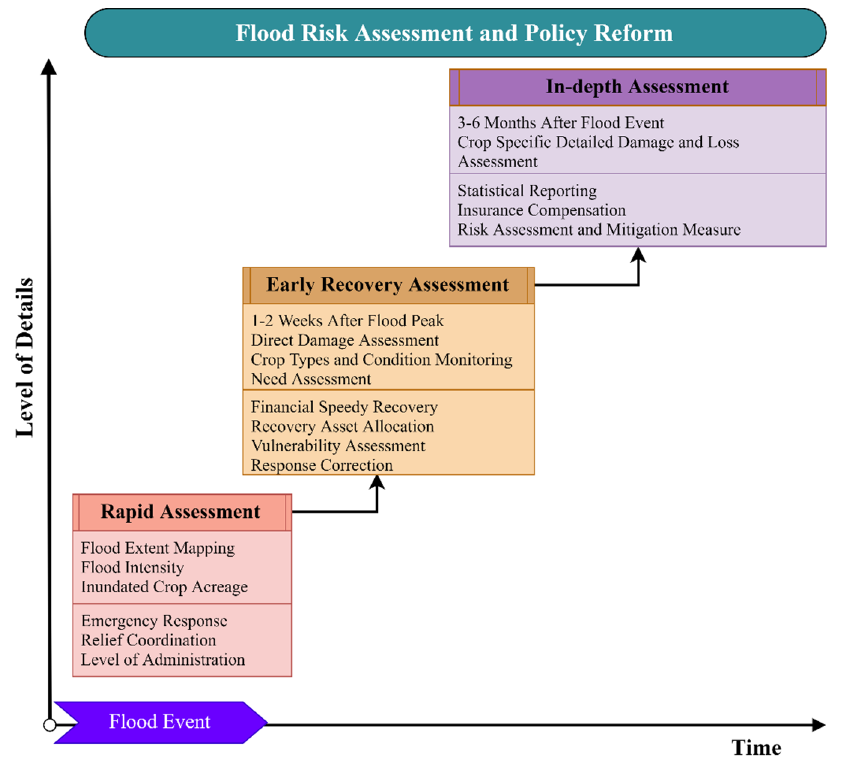
Figure 1. Types of flood assessment in various phases (adapted from Di et al. [17] and WMO [18]).